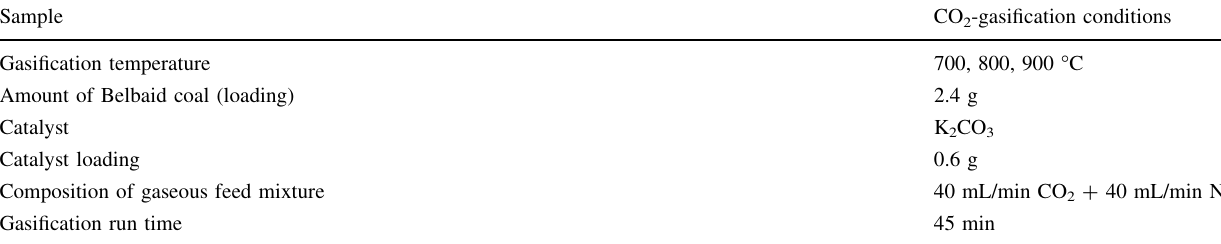
Table 2 Experimental conditions of CO 2 gasification of coal